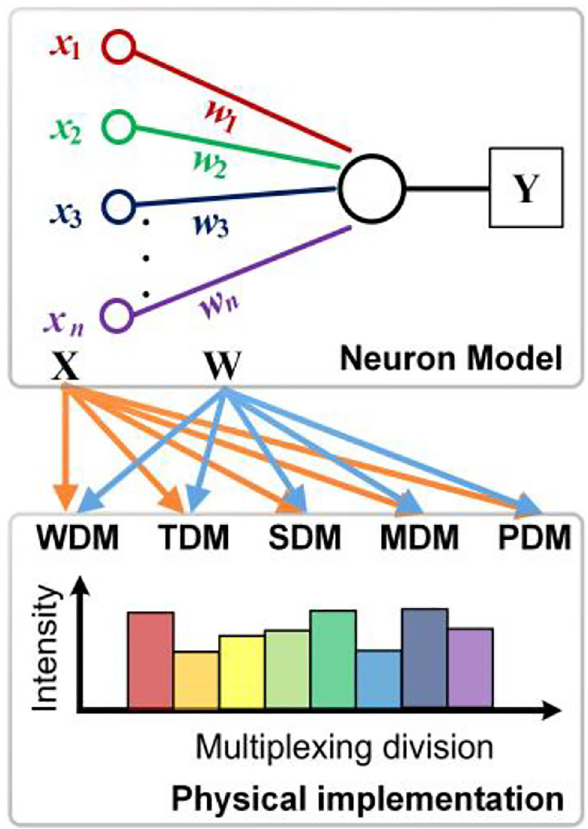
Figure 2: The model of a single